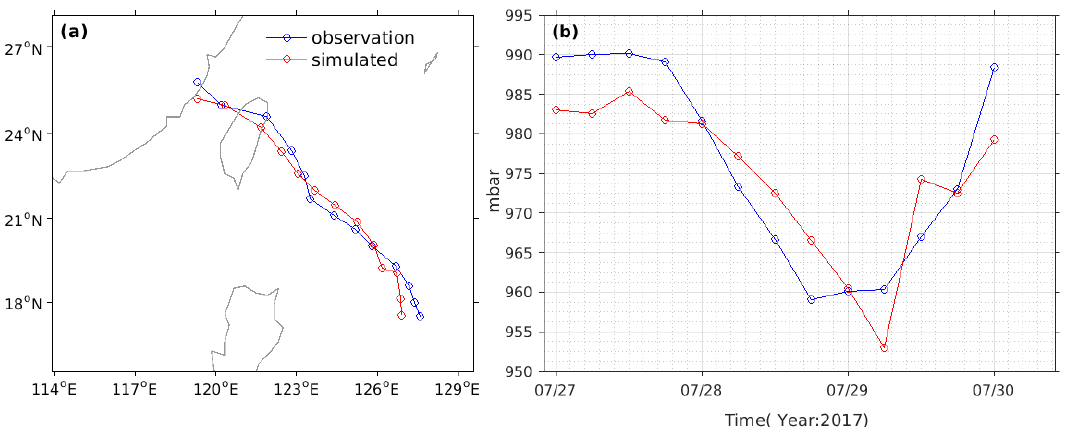
Figure 3. Comparison between simulated and observed typhoon ( a ) tracks and ( b ) intensities. Here, the Japan Meteorological Agency (JMA) best track data was used, with the coloured blue circles in ( a ) denoting the typhoon centre position every six hours starting at 0000 UTC on 27 July 2017.